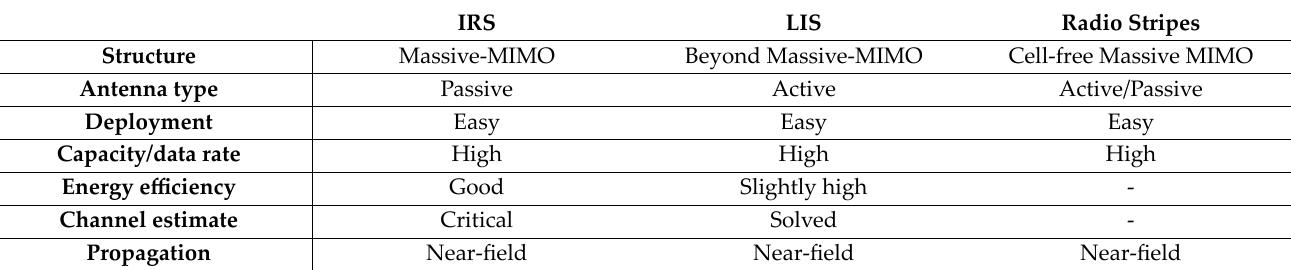
Table 4. Comparison between IRS, LIS, and Radio